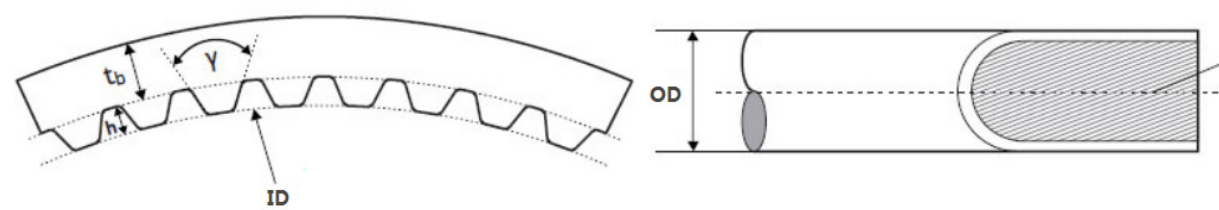
Figure 2. Schematic of the experimental facility (T/P: temperature and pressure sensors, FM: flow meter, DP: differential pressure sensor, and SG: sight glass). ( a ) Instrumentation of the test rig. ( b ) Detailed instrumentation of the test section.